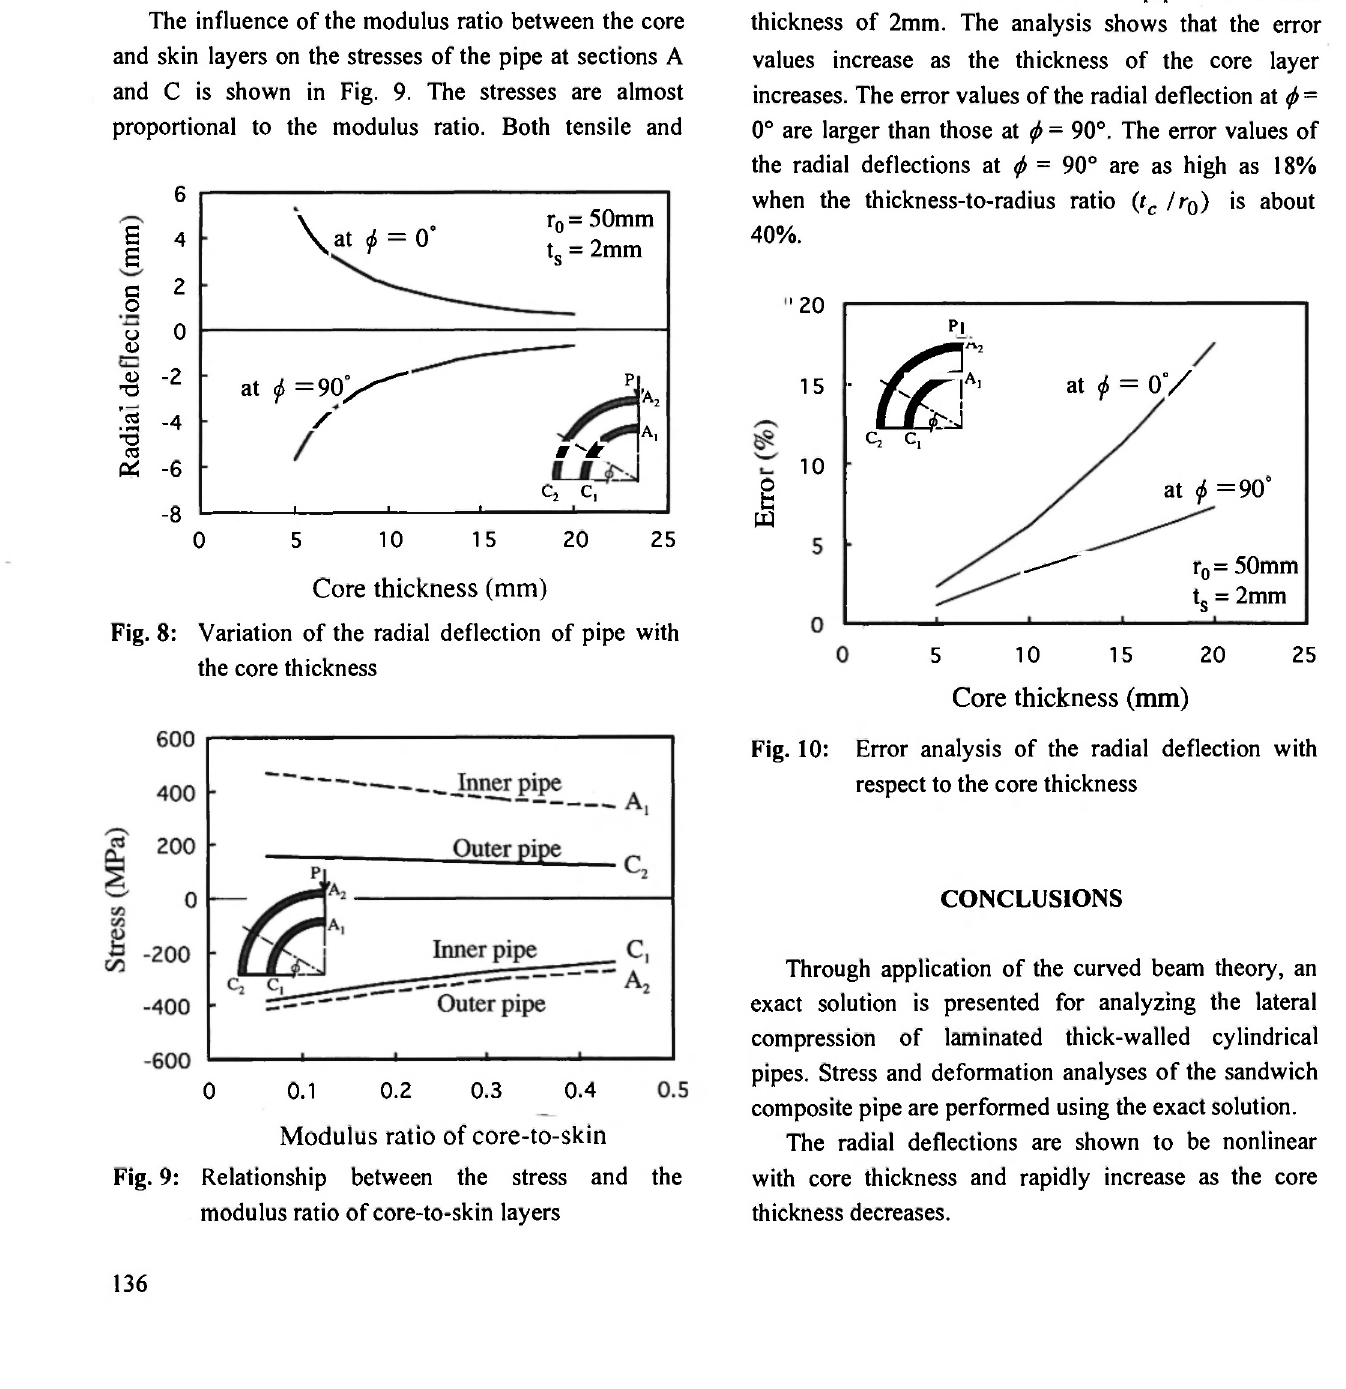
compressive stresses at the inner and outer pipes tend to decrease slightly when the modulus ratio of core-to-skin layers increases because the deformation of the pipe decreases as the core stiffness increases. The core material with a high stiffness intensifies the transfer of the force from the inner to outer layers. Based on the thick curved beam and the strain energy theories, the errors for the radial deflections of the sandwich pipe are analyzed. Figure 10 shows the error analysis of the radial deflections with respect to the core thickness of the sandwich pipe with a skin thickness of 2mm. The analysis shows that the error values increase as the thickness of the core layer increases. The error values of the radial deflection at φ = 0° are larger than those at φ = 90°. The error values of the radial deflections at φ = 90° are as high as 18% when the thickness-to-radius ratio (t c / r 0 ) is about 40%.